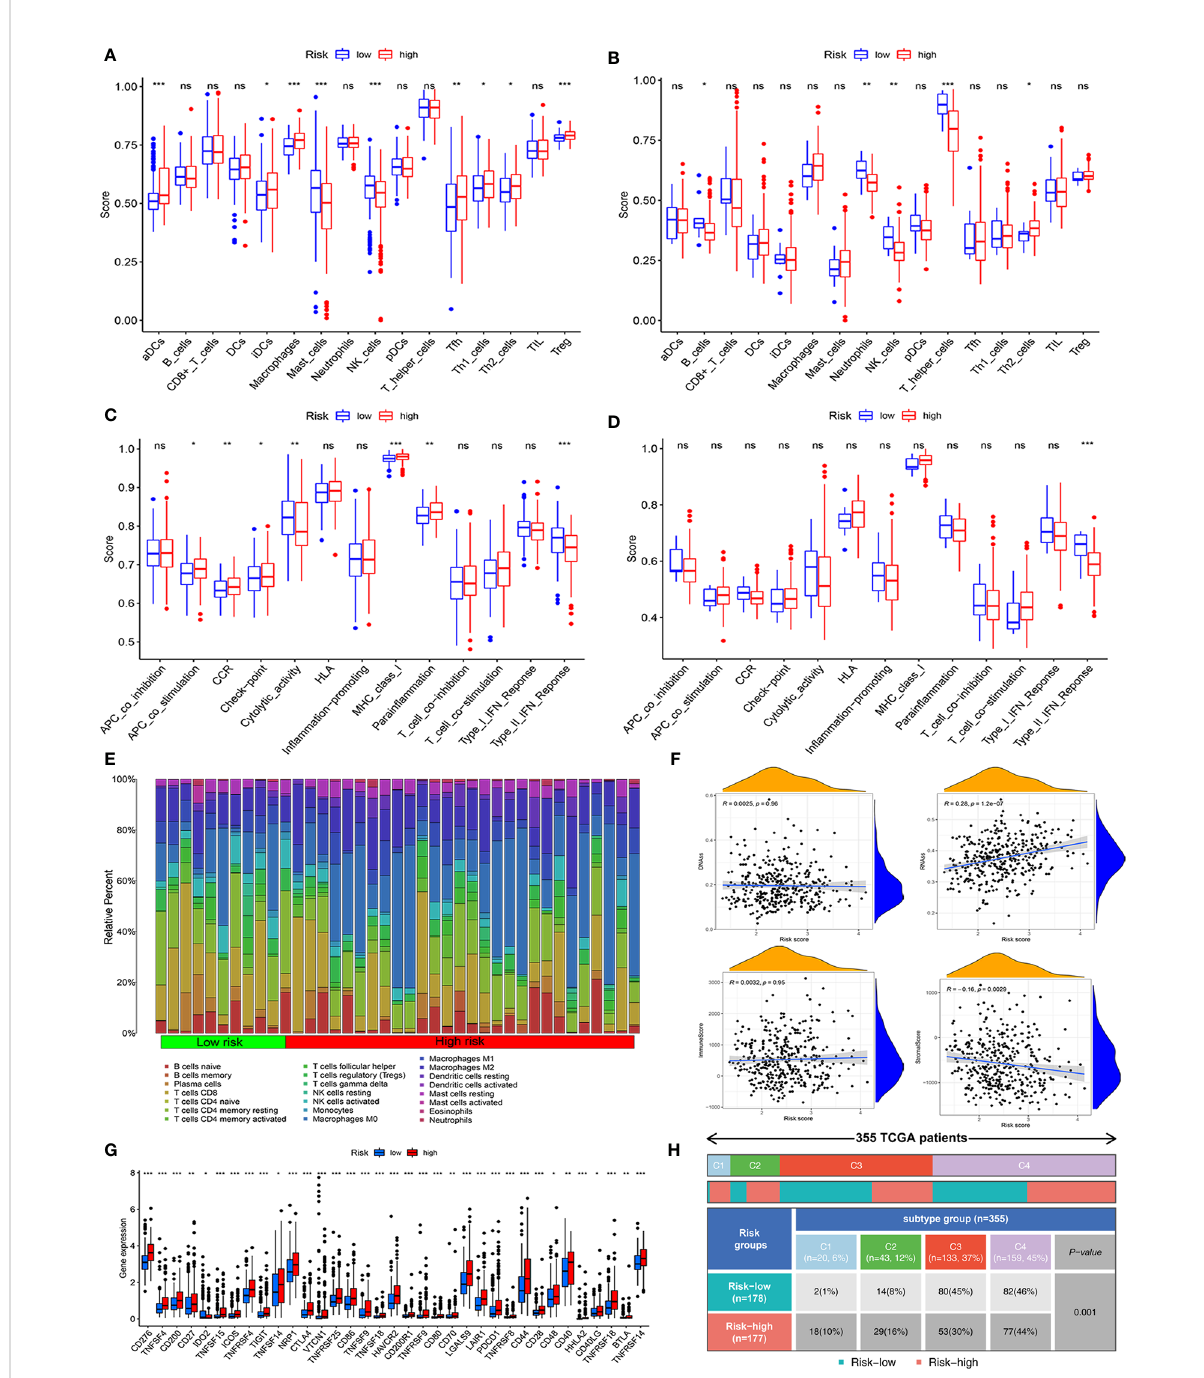
FIGURE 4 Assessment of immune status, tumor microenvironment, and immune checkpoints of mitochondria-related prognostic signatures. (A, B) The scores of 16 immune cells were detected by ssGSEA analysis based on low- and high-risk groups in the TCGA cohort and the ICGC cohort. (C, D) The scores of 13 immune-related functions were determined by ssGSEA analysis based on risk groups in the TCGA cohort and the ICGC cohort. (E) The fraction of different immune in fi ltration cells in low- and high-risk groups. (F) Relevance of risk scores to RNAs, DNAs, Immune, and Stromal Score. (G) Immune checkpoints and gene expression in high- and low-risk groups. (H) The association between immune subtypes and risk groups in HCC patients. *P<0.05, **P<0.01, ***P<0.001, ns, not